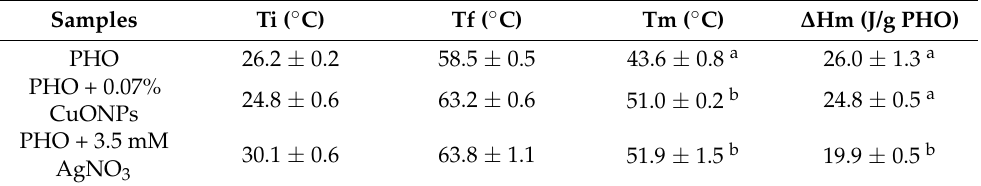
Figure 5. DSC thermograms of the first heating run of PHO films with and without NPs.